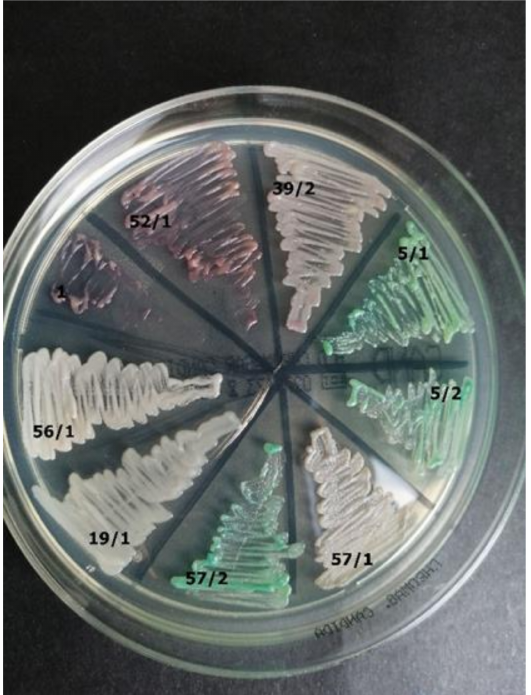
Figure 6. Identification of yeast-like fungi (Table 3) on CHROMagar Candida (private